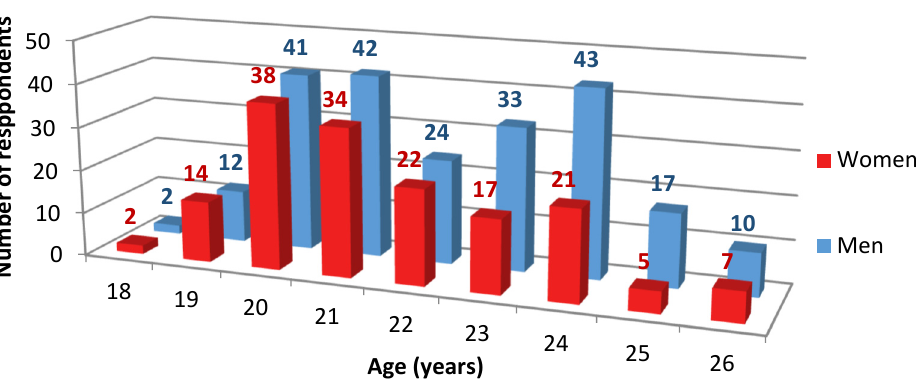
Figure 2. Determination of sample size using the Sample Size Calculator [38].